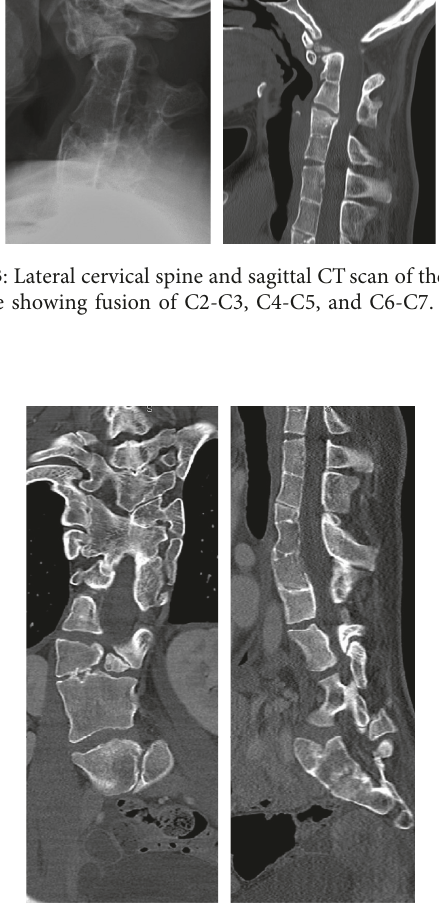
Figure 4: Coronal and sagittal CTscan of the thoracolumbar spine and sacrum demonstrating a variety of vertebral segmentation defects including hemi-, wedge-, butterfly-, and block vertebra.